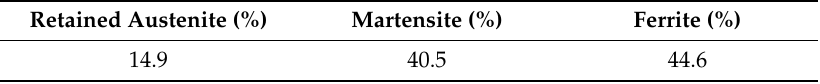
Table 3. Rietveld analysis results for phase quantification for the austempered